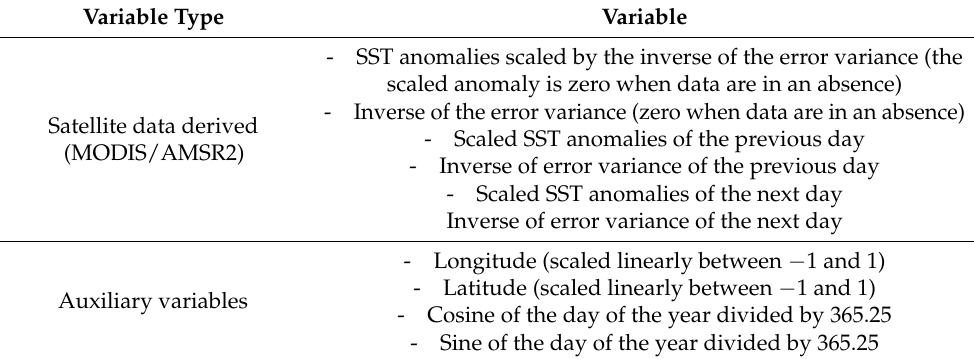
Table 1. Summary of input variables used in DINCAE to reconstruct MODIS and AMSR2 SSTs in this